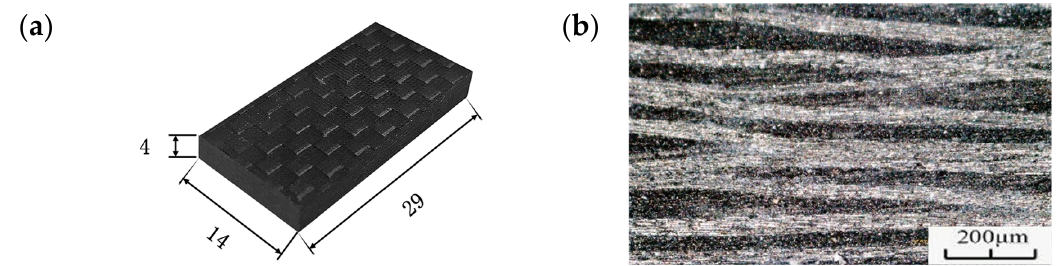
Figure 3. ( a ) Dimensions and ( b ) microscope image of the CFRP